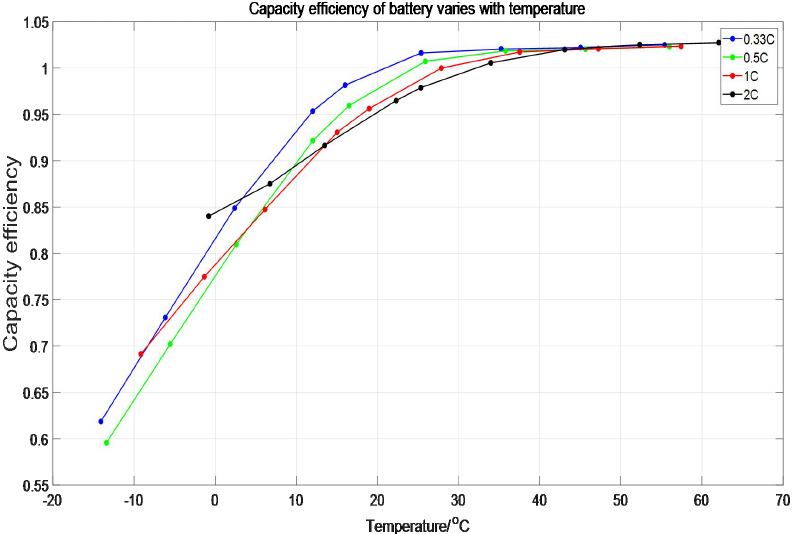
Figure 6. The capacity efficiency of the battery varies with the average temperature of the battery